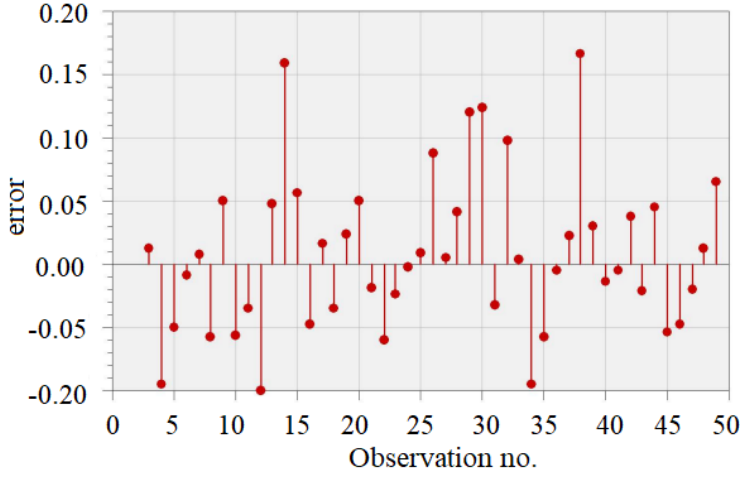
Figure 3. The best model for S4_ms (with lag 1 regressor).